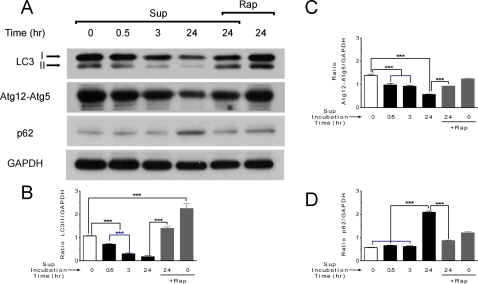
Western blot analysis of autophagy related proteins.(A) The LC3-II level is reduced after 3 or 24 hr exposure to SIV-infected microglia supernatant and this decrease effect is blocked when is pretreated with rapamycin (2 µM). The protein level of elongation complex Atg12-Atg5 is also reduced, and again the effect is blocked in the presence of rapamycin. The protein level of p62 is increased for similar conditions with SIV-infected microglia supernatant, and the increase is blocked in the presence of rapamycin. GAPDH protein was used in these experiments as the loading control. One representative experiment of n = 4 is shown. (B, C and D) Ratios between LC3-II, Atg12-Atg5, p62, respectively, normalized to GAPDH. Data are reported as mean±SEM (n = 4). *** P<0.001.